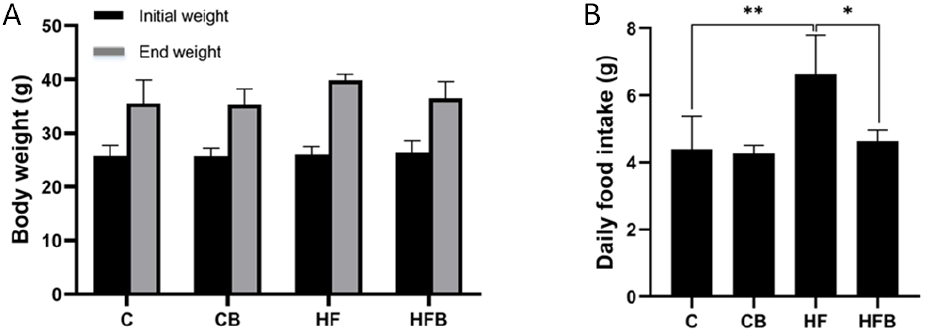
Figure 1. Effect of betaine supplementation on body weight ( A ) and daily food intake ( B ) on mice. Values are mean ± SEM ( n = 9). * p < 0.05, ** p < 0.01. C: control, CB: control with 1% betaine, HF: high fat diet, HFB: HF with 1% betaine.